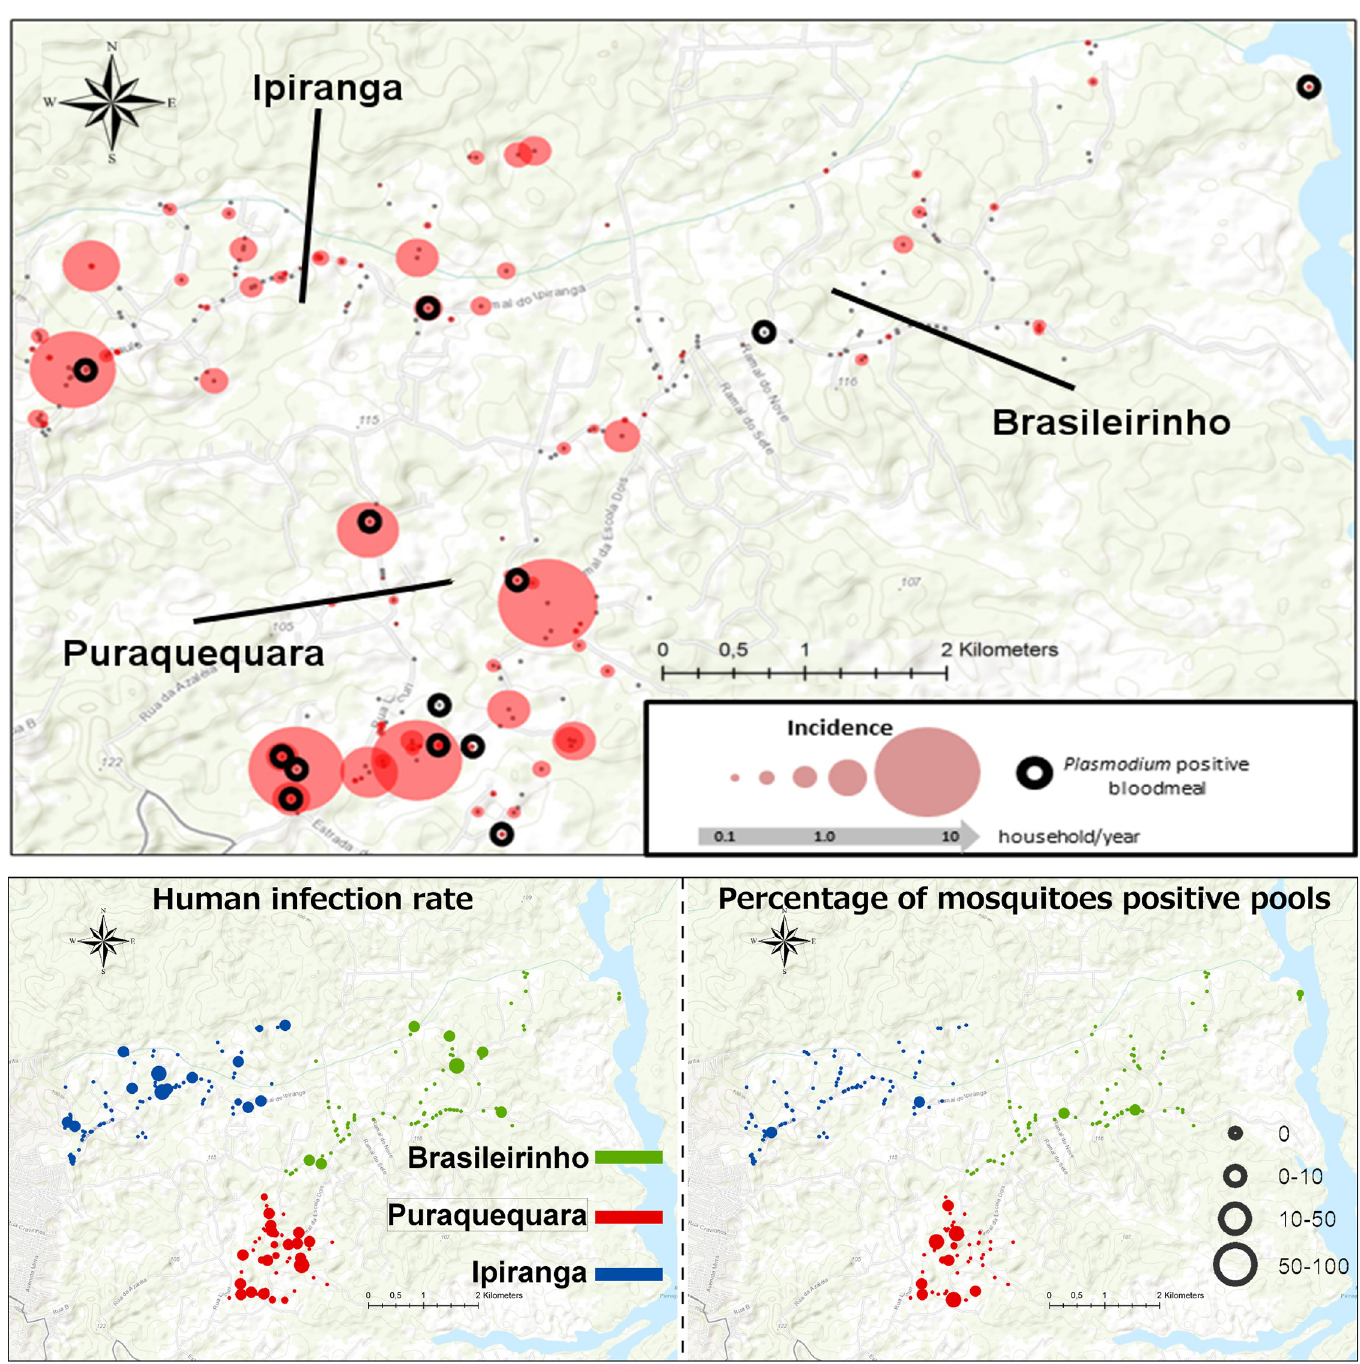
Fig 2. Spatial representation of human Plasmodium infection rate and proportion of Plasmodium DNA positive pools in the study area. This study was conducted in the Brasileirinho, Puraquequara and Ipiranga communities, in a peri-urban area of Manaus, Western Brazilian Amazon. Culicid xenosurveillance was good in detecting malaria clusters in the study site, and demonstrated coinciding hotspots. This figure was created with Open Street Maps, which are licensed under ODBL 1.0.